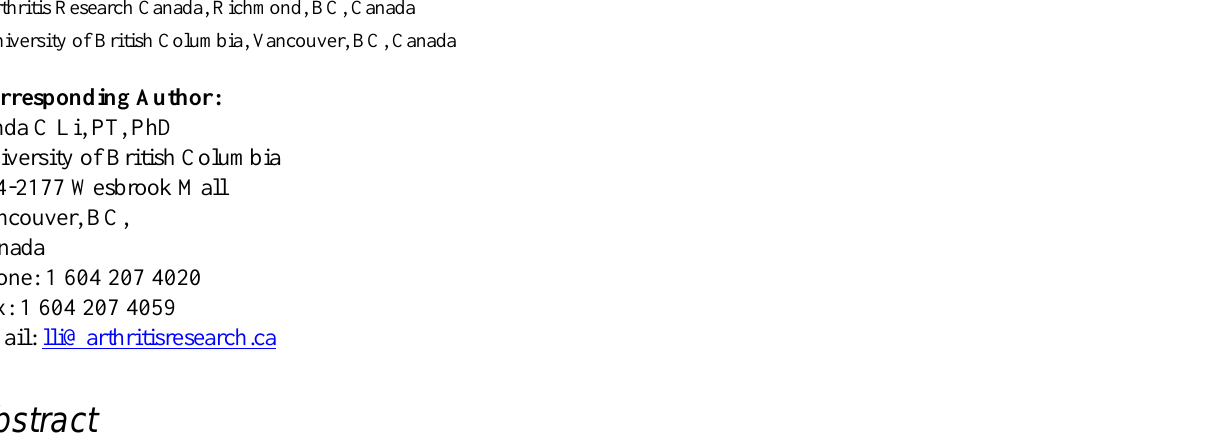
Otago Exercise Program; DVD; aging; falls; physical therapy; qualitative